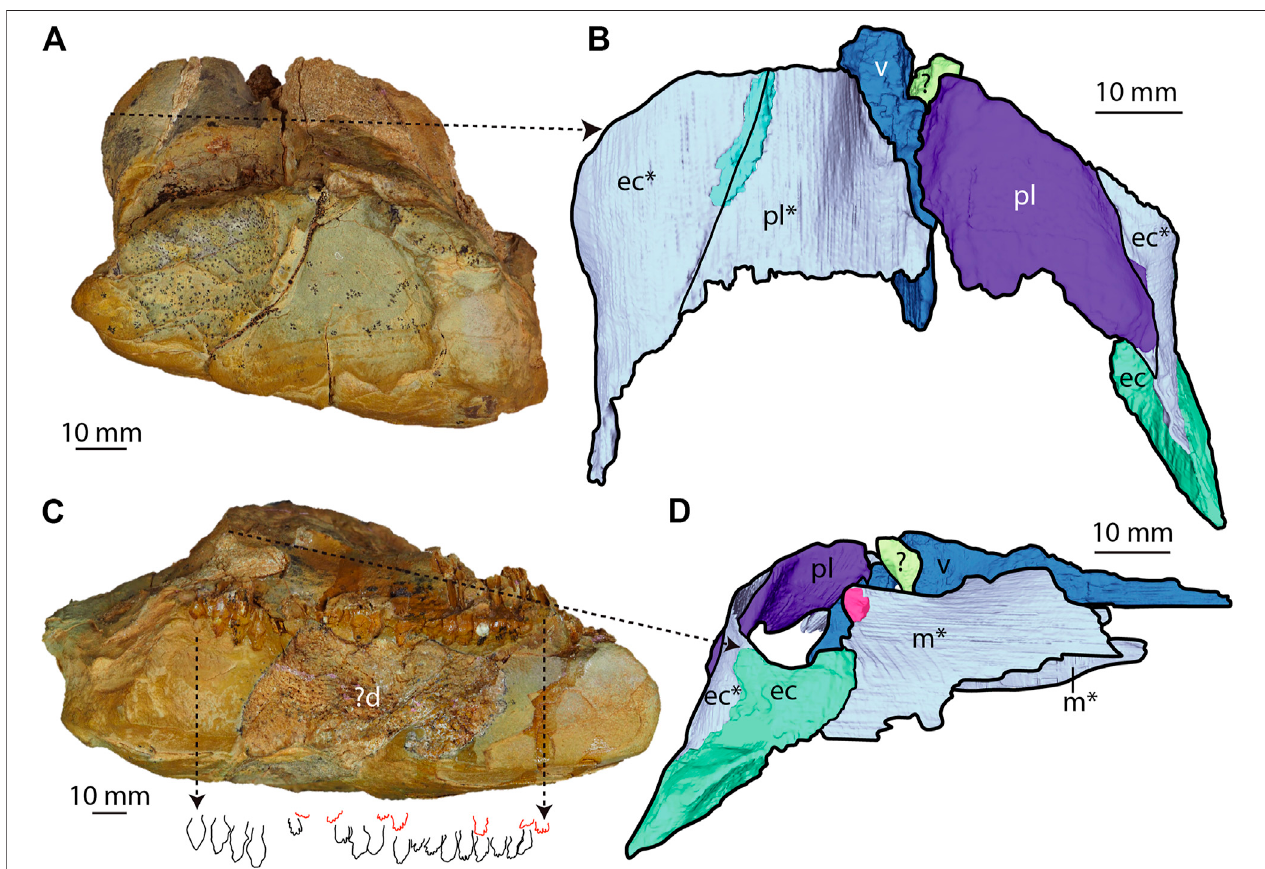
FIGURE3| PosteriorandrightlateralregionsofSAMAP40536 (A,B) Posteriorview. (A) Actualspecimen. (B) 3Dreconstruction. (C,D) Rightlateralview. (C) Actual specimenshowingtheoutlineofmaxillarytoothrowimpressions,includingthefunctional(blackoutline)andreplacement(red)teeth.Abbreviations:?d,possiblydentary; ec, ectopterygoid; m, maxilla; pl, palatine; v, vomer. 3D models of bones based on impressions are denoted with an asterisk (*).